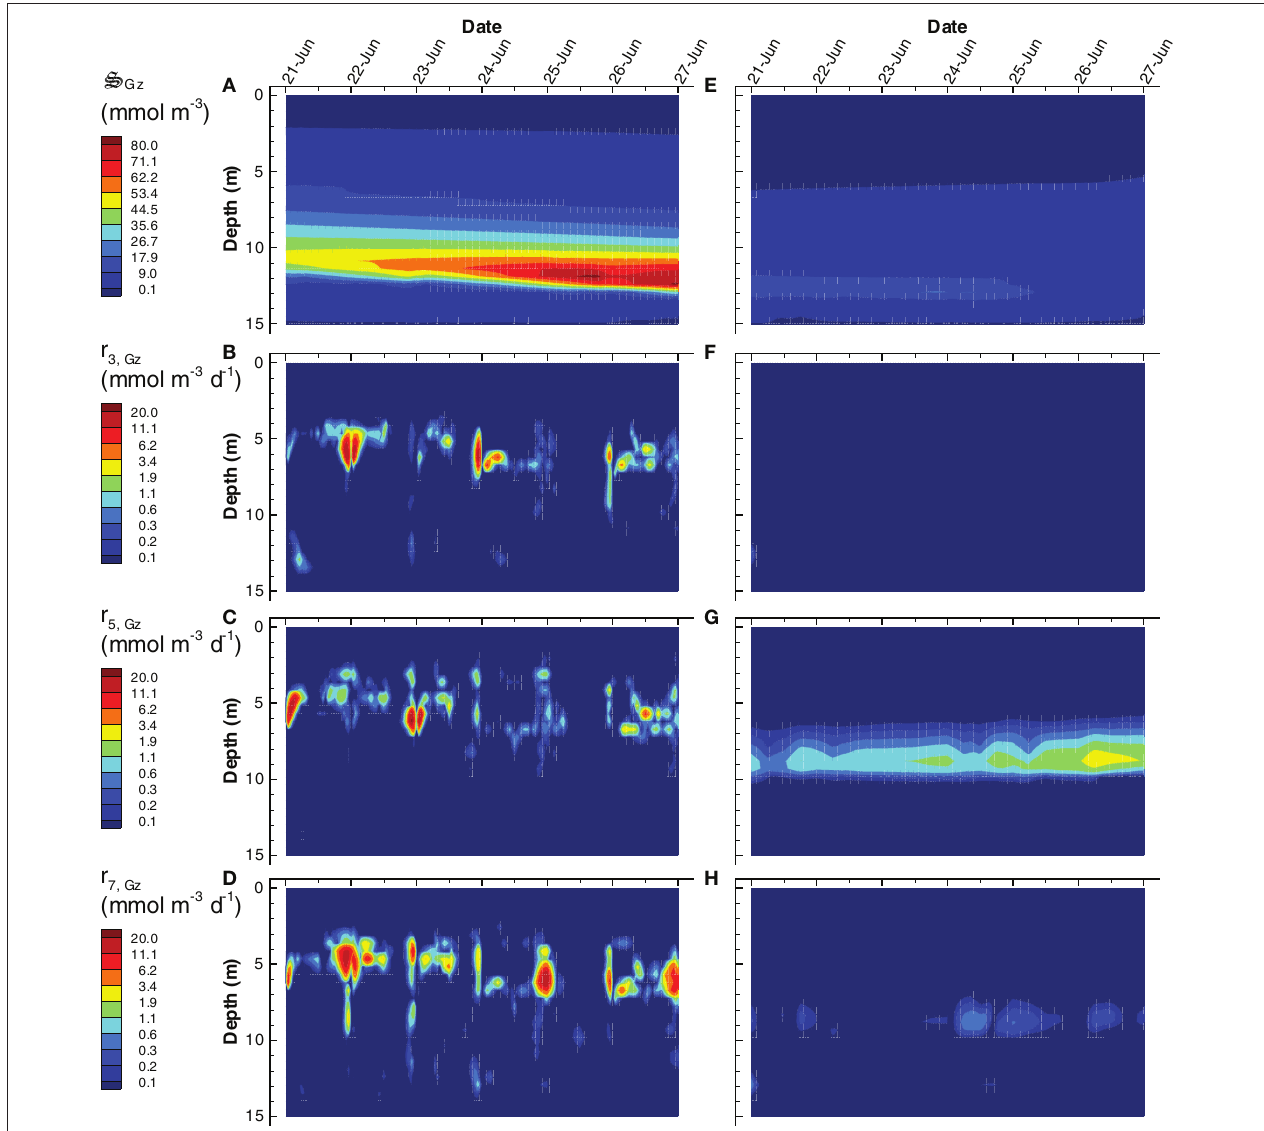
FIGURE 11 | Contour plots of grazer concentration, [ S Gz ] (A,E) and rates of predation on, grazers, r 3, Gz (B,F) , bacteria, r 5, Gz (C,G) , and photoheterotrophs, r 7, Gz (D,H) for the SIO (A–D) and LIO (D–H)